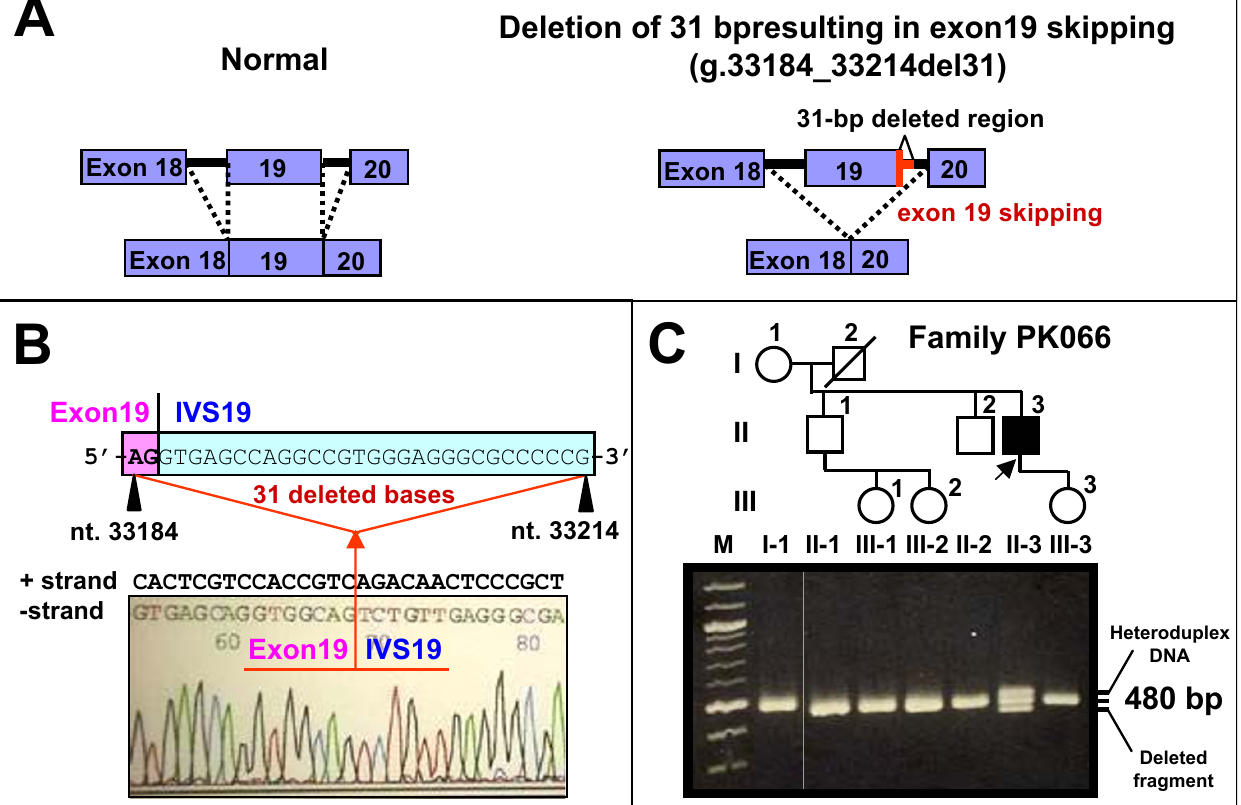
Figure 2 Novel PKD1 -splicing defect identified in family PK066. A. Diagram showing splicing defect resulted from a deletion of 31 bp in PKD1 . The deletion of 31 bp (g.33184_33214del31) involves the end of exon 19, splice-donor site and a part of intron 19, resulting in exon 19 skipping in the PKD1 -RNA transcripts. B. Direct sequencing analysis of PKD1 - genomic DNA from the proband. The sequencing result shows the 31-nucleotide deletion including the two last nucle- otides in exon 19 and the first twenty-nine nucleotides in adjacent intron 19 (g.33184_33214del31) as compared with the sequence of HUMPKD1GEN, GenBank Accession No. L39891. C. Direct detection of the 31-bp deletion (g.33184_33214del31) in the family PK066. The detection of 31-bp deletion (g.33184_33214del31) in members of the family PK066 was directly performed by genomic DNA amplification. Only the proband (II-3) in this family carries the deletion. M represents 100 bp ladder-DNA